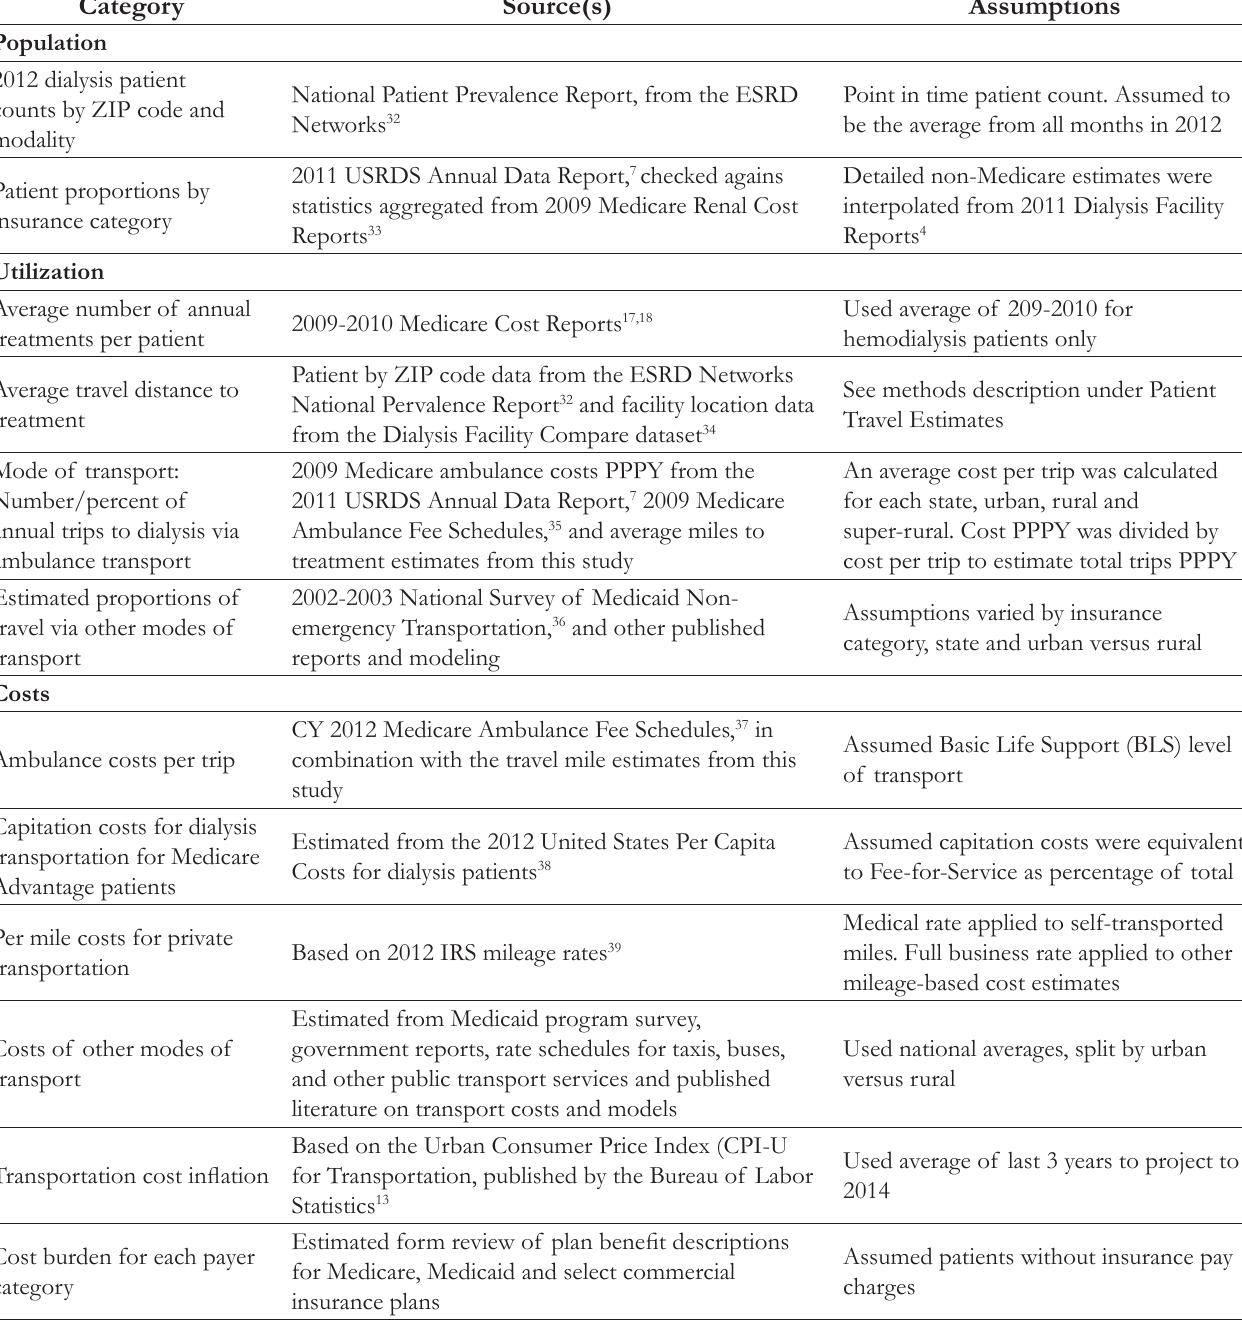
Table 2. Summary of Data Sources and Assumptions Used for Estimating Transport Costs